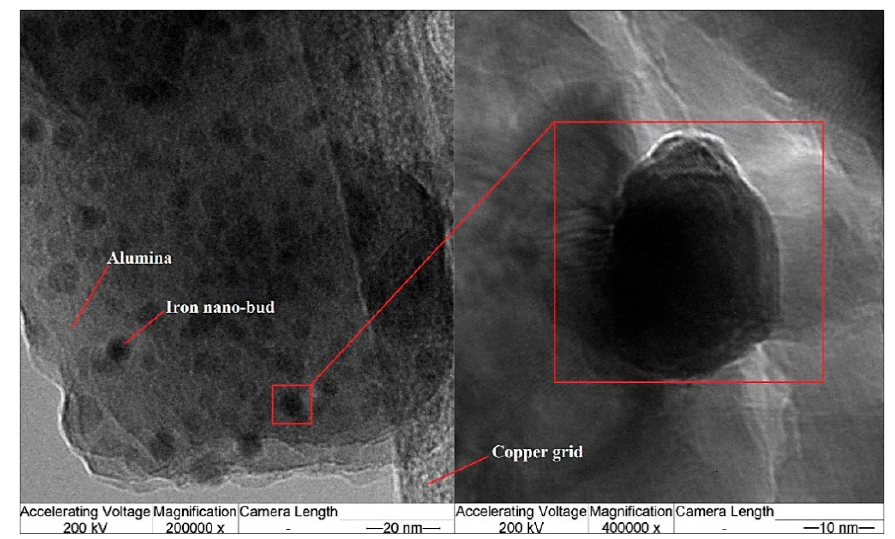
Figure 3. TEM micrographs of iron nanoparticles grown over alumina support.